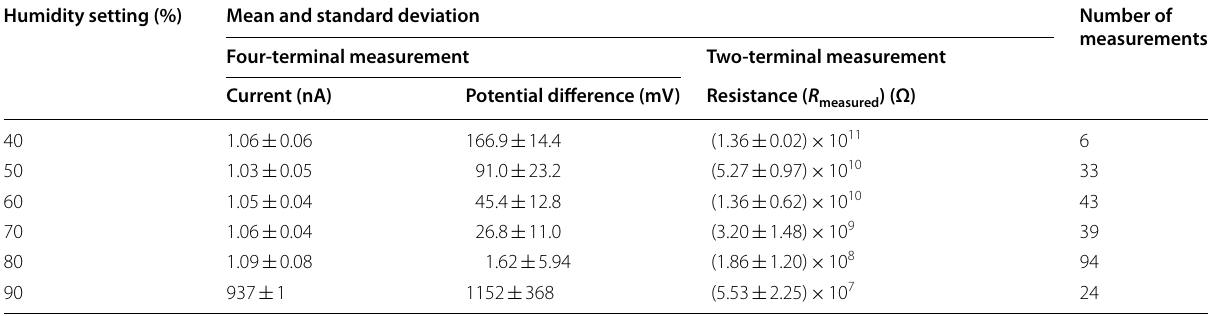
Table 4 Statistical comparison of repeated measurements Humidity setting (%)